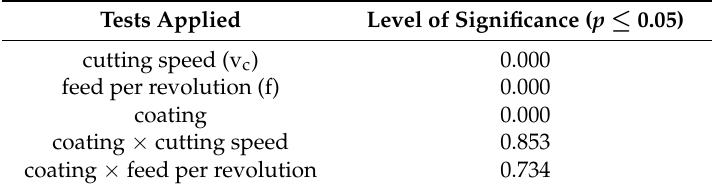
Table 5. Significance level of the effect of cutting parameters on the average cutting torque (M c